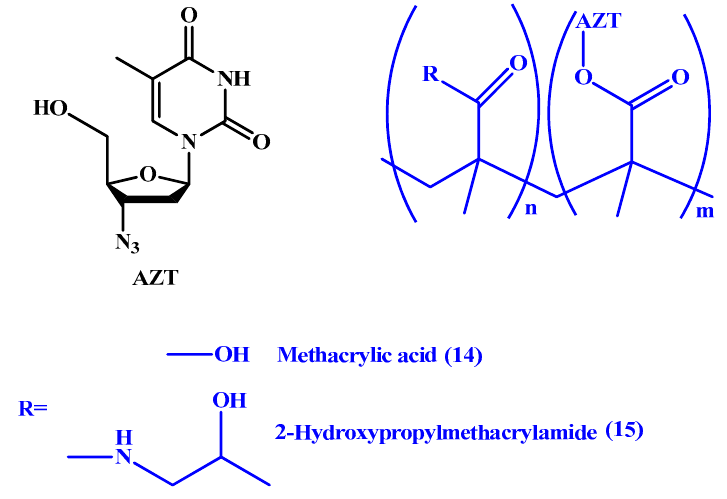
Figure 8. Chemical structures of PMAA-AZT ( 14 ) and HPMA-AZT ( 15 ).